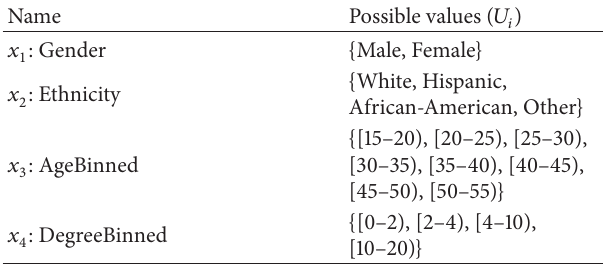
Table 1: Significant Attributes (as determined by ERGM).